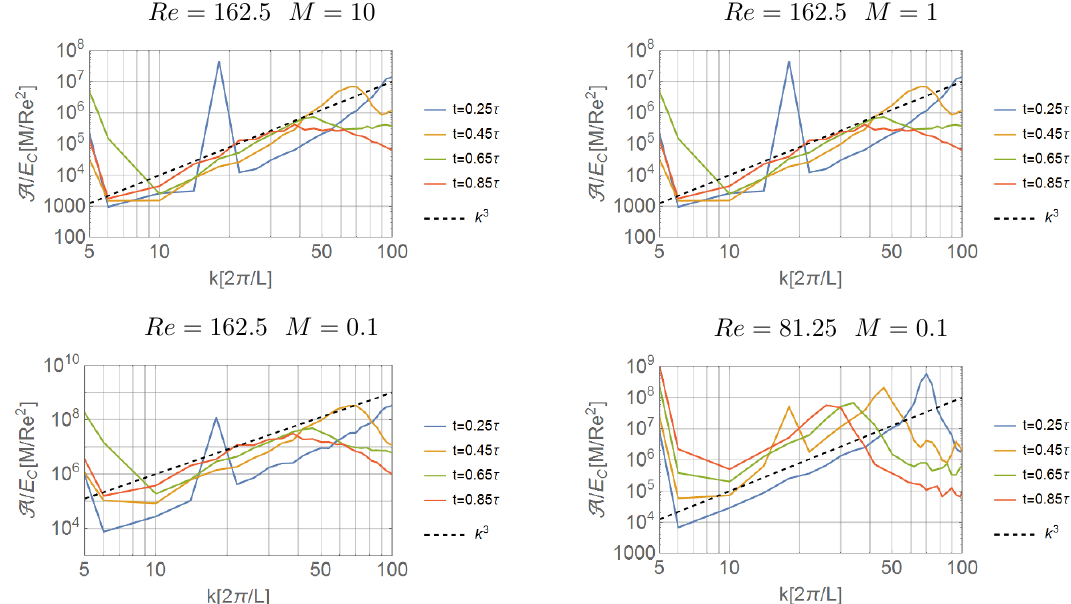
Figure 20 . A ( t; k ) =E C ( t; k ) for three dimensional turbulent (cid:13)ows with initial mode n = 4 at intermediate times. The dashed line is proportional to k 3 .